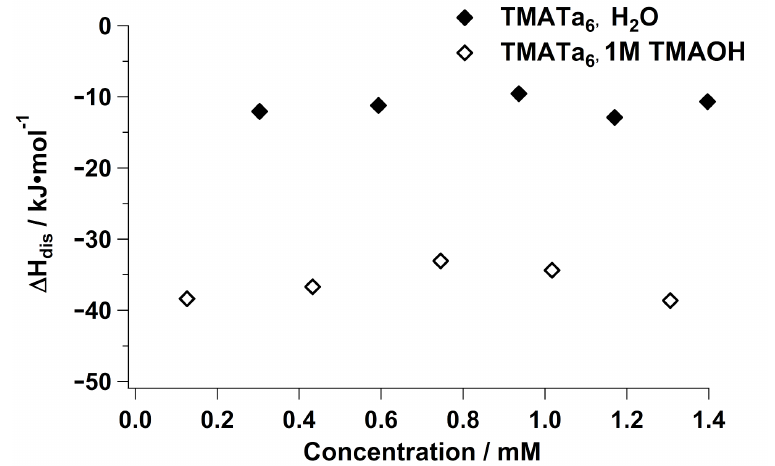
Figure 4. Enthalpy of dissolution of TMA–Ta